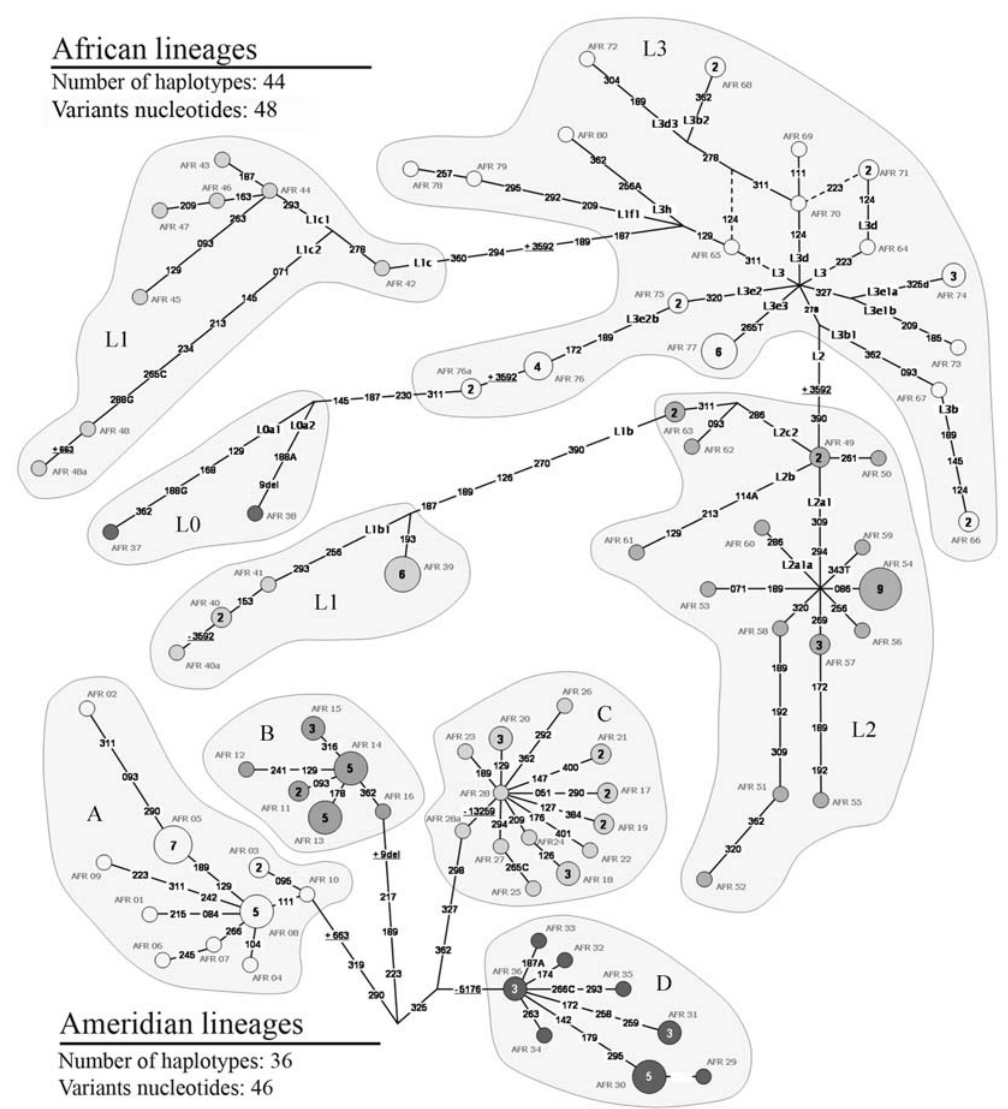
Figure 2 - Networks of African and Amerindian lineage groups. The first hypervariable region (HVS-I) variant nucleotides are indicated along the branches connecting the haplotypes. For the exact nucleotide position 16000 should be added to the numbers. Transversions are indicated by the nitrogen base and deletions by “d”. The numbered haplotypes refer to multiple occurrences. The restriction sites and the 9 bp deletion are